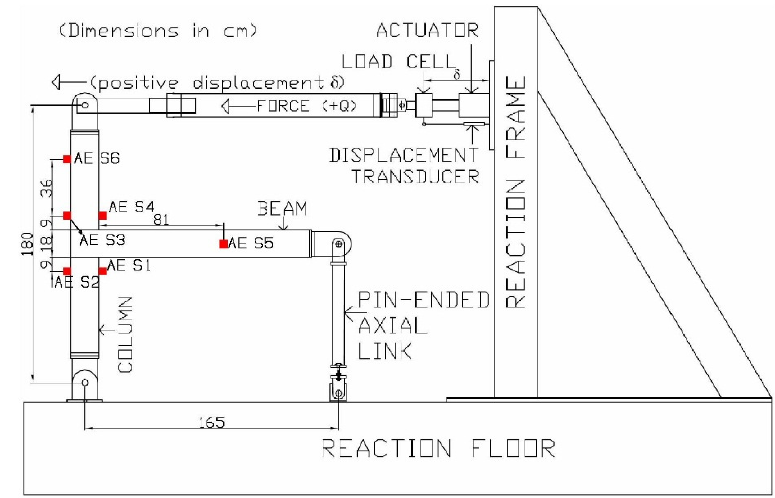
Figure 11 . Experimental set up for the beam ‐ column connection subjected to cycling loads. A load cell and a displacement transducer installed on the actuator measured the overall horizontal force, Q , and the corresponding horizontal displacement, δ , while strain gauges attached to the reinforcing steel measured the corresponding strains (Figure 12b). Six AE low-frequency VS30-V sensors (Figure 11) were placed on each specimen. In all the channels, 25–180 kHz pass filters were used; signals were preamplified 34 dB AE , and 40 dB AE was set as the acquisition threshold.